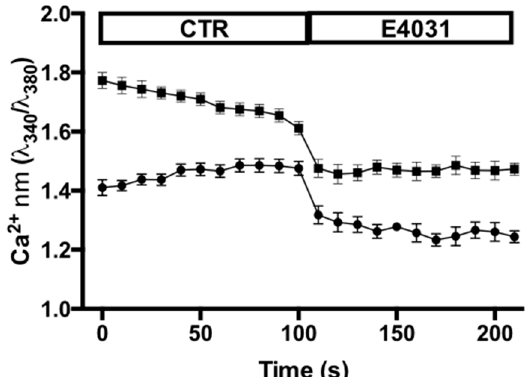
Figure 8. Effect of E4031 on intracellular Ca 2+ in PANC-1 cells cultured onto FN (circles) or DM plus Hypo-PSC-CM (squares). [Ca 2+ ] i was determined by Fura2 fluorescence intensity as detailed in Materials and Methods in the absence (CTR) or in the presence of 40 µ M E4031 (E4031). At least 25 cells per condition from 3 independent experiments were analyzed. Data are reported as Ca 2+ ratio at λ 340 / λ 380 . Data are mean ± SEM. Average values of PANC-1 in control versus E4031 conditions on FN are significantly different: p < 0.0001. Average values of PANC-1 in control versus E4031 conditions on DM plus Hypo-PSC-CM are significantly different: p < 0.0001. Average values of PANC-1 in control conditions on FN versus DM plus Hypo-PSC-CM are significantly different: p < 0.0001. p values were determined by ANOVA test (significant level set to p < 0.05).